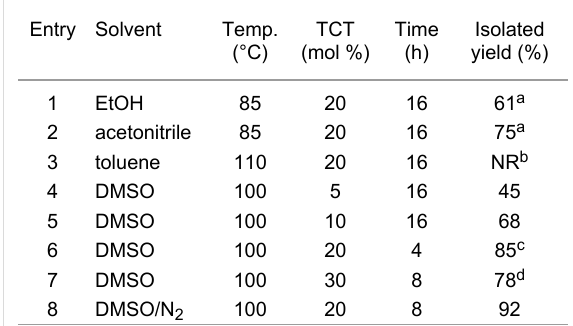
Table 1: Method development of the TCT-catalyzed Pictet–Spengler reaction for the condensation of tryptamine ( 1 ) and 4-tolualdehyde ( 2a